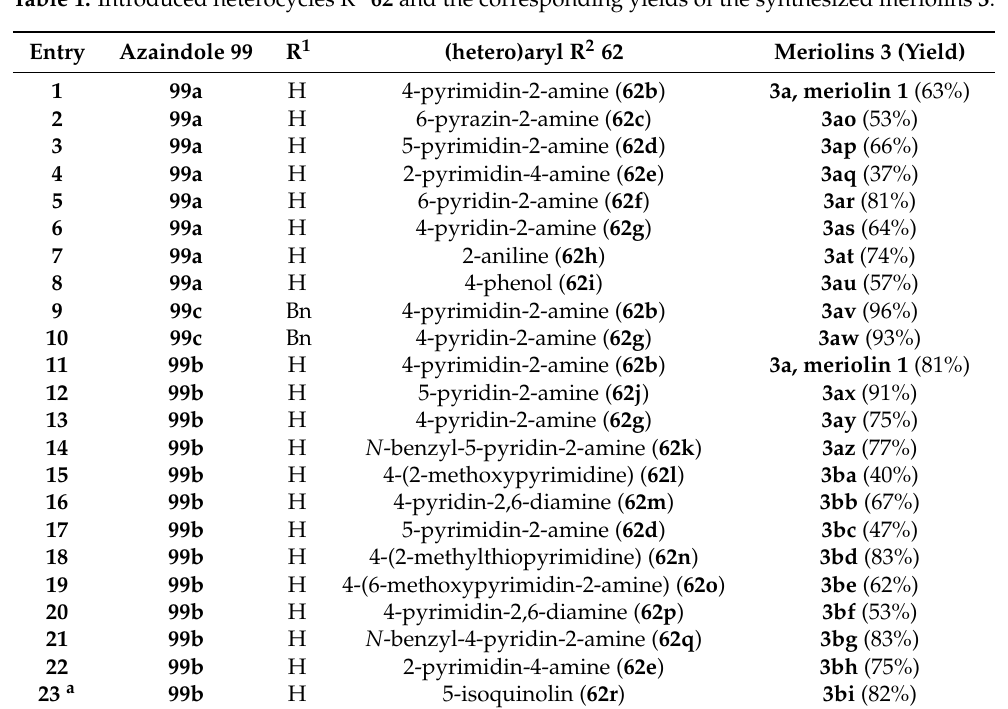
Figure 32. MBSC sequence for the synthesis of meriolins 3a and 3ao - bi by Müller [18,63]. Table 1. Introduced heterocycles R 2 62 and the corresponding yields of the synthesized meriolins 3